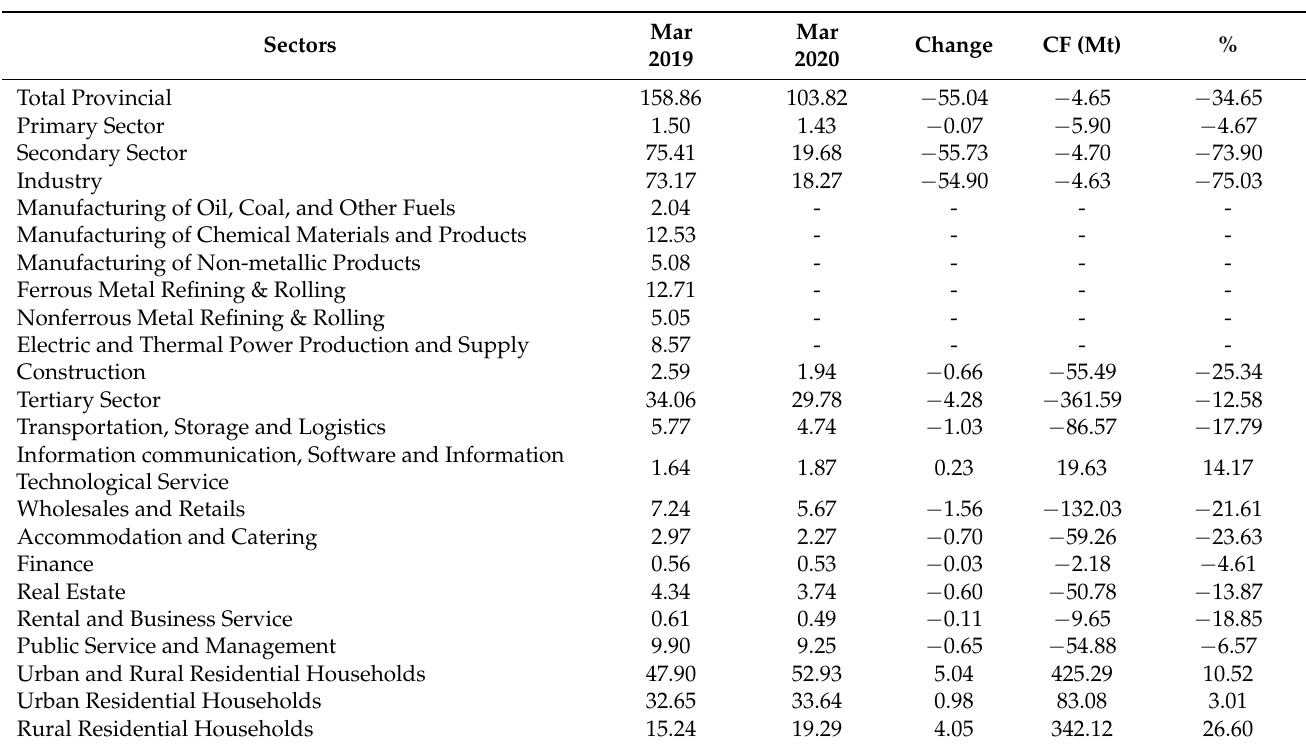
Table 7. Hubei sectoral carbon footprint changes of February 2020 compared to February